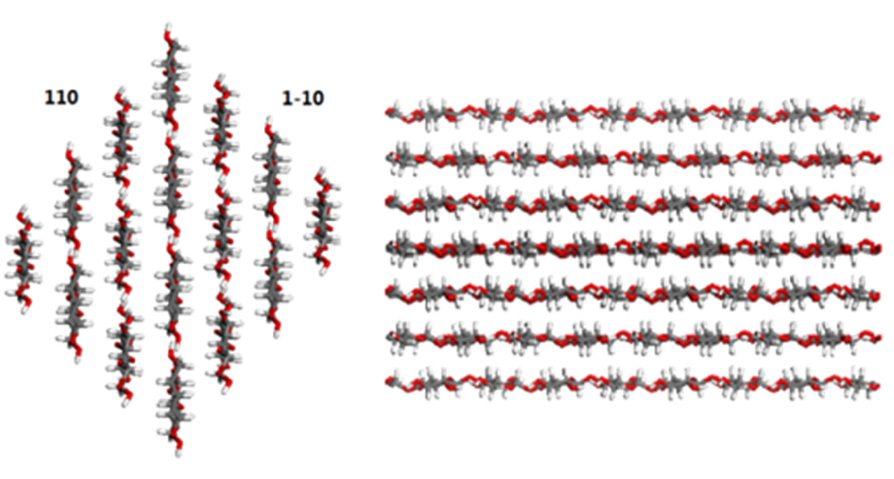
Figure 7. The crystalline cellulose model.